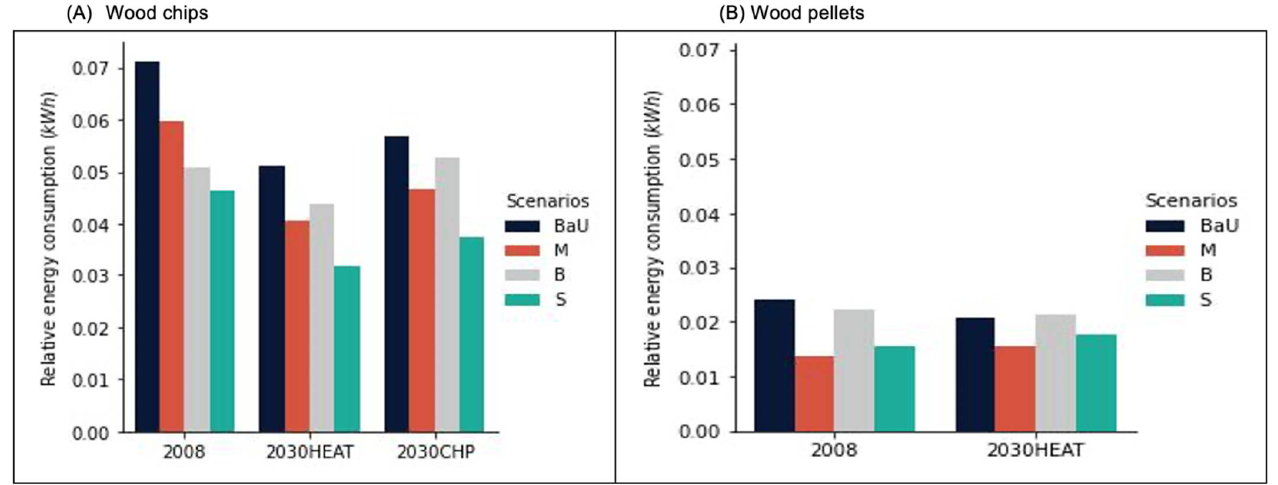
Figure 7. Relative fossil fuel energy consumption for wood chip ( A ) and wood pellet ( B ) value chain scenarios, expressed in kWh of fossil fuel energy consumed per bioenergy generated.